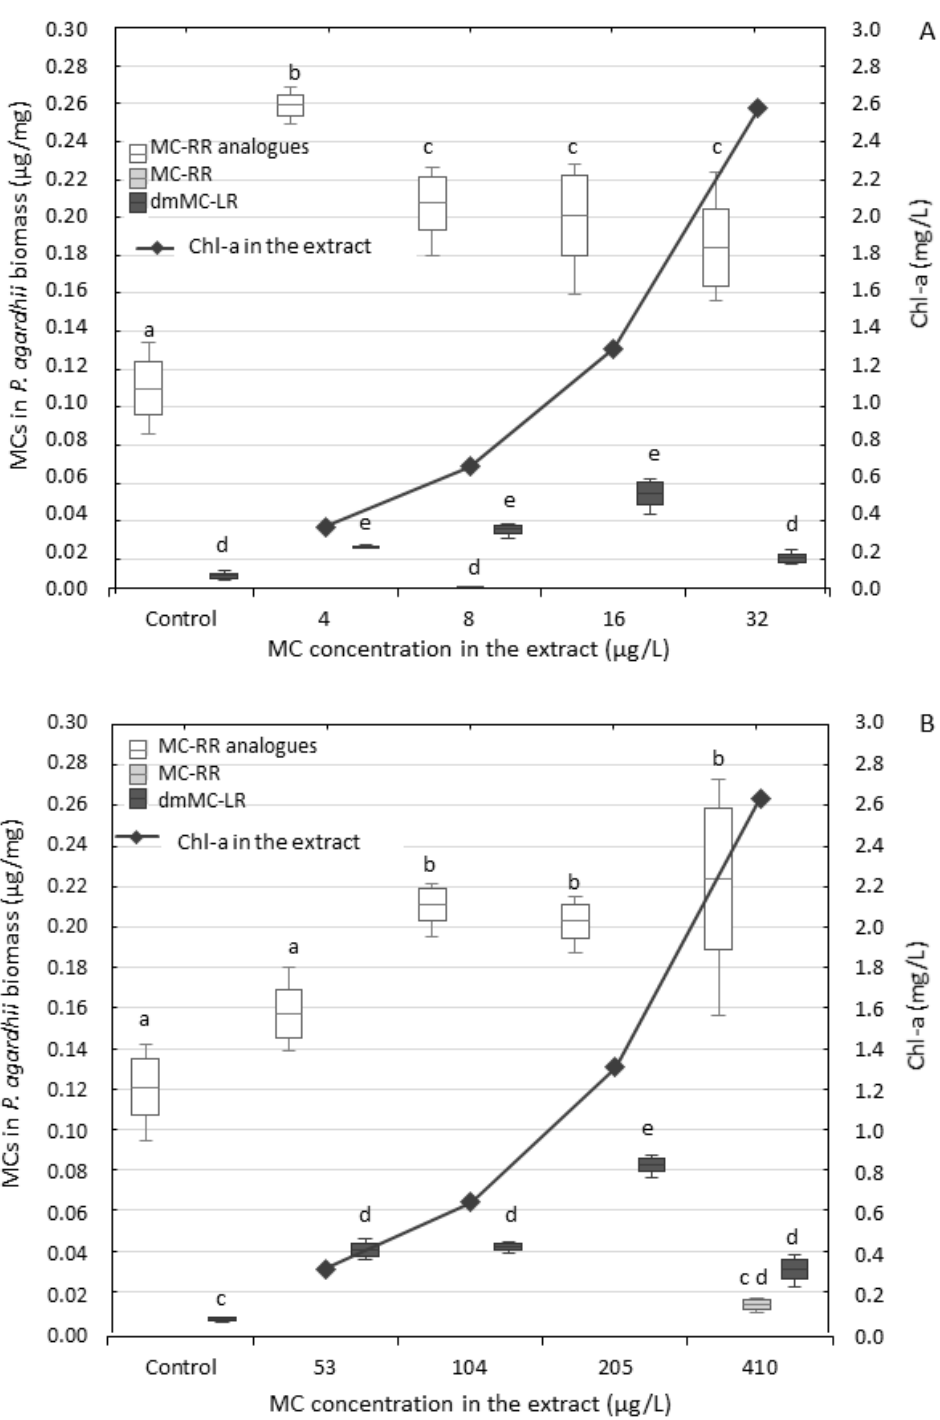
Figure 4. Content of particulate MC isoforms in the biomass of P. agardhii after the seven-day exposure to the extracts Pa-A ( A ) and Pa-B ( B ). Data are expressed as means ± 0.5 SD, n = 3. Bars means min–max. values. Different lowercase letters (a–d) indicate statistically significant differences between treatments for MC-RR analogues, MC-RR and dmMC-LR (ANOVA, Tukey’s test, p < 0.05).